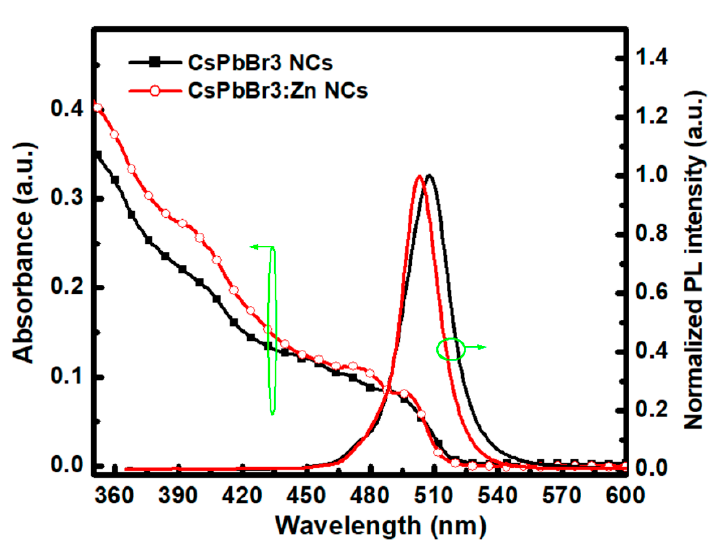
Figure 2. Absorption and PL spectra of CsPbBr 3 and CsPbBr 3 :Zn NCs dispersed in hexane.